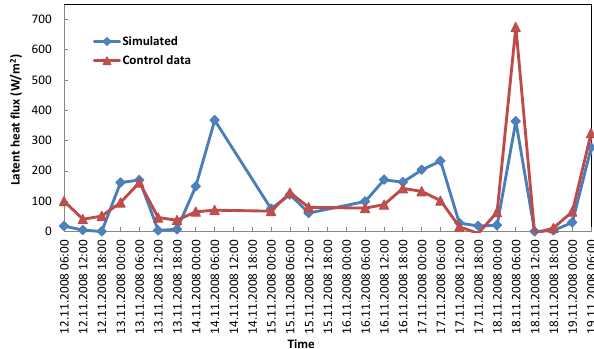
Figure 4. Comparison of best model performance (simulation 1) with control data, for 6-hourly LHF prediction during typhoon Fig. 4 Comparison of best model performance (simulation 1) with control data, for six-hourly 2 Noul. LHF prediction during typhoon Noul 3